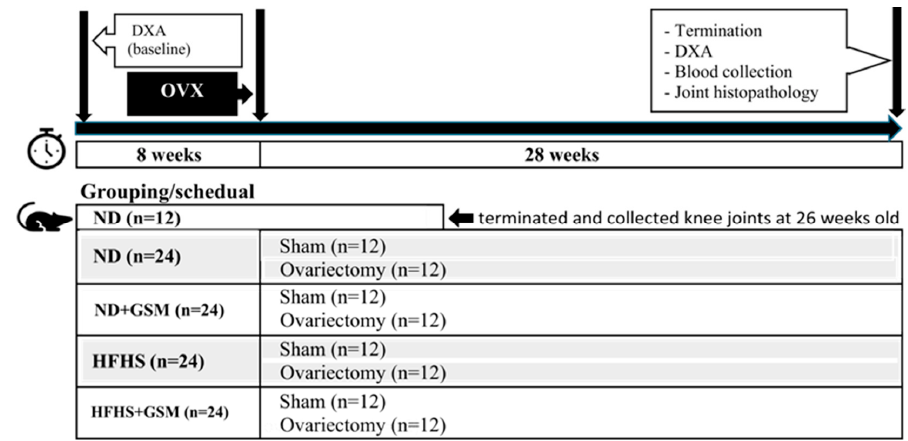
Figure 1. Experimental schedule for obesity-induced osteoarthritis in the rat model with greenshell mussel. DXA = Dual X-ray energy absorptiometry; OVX =